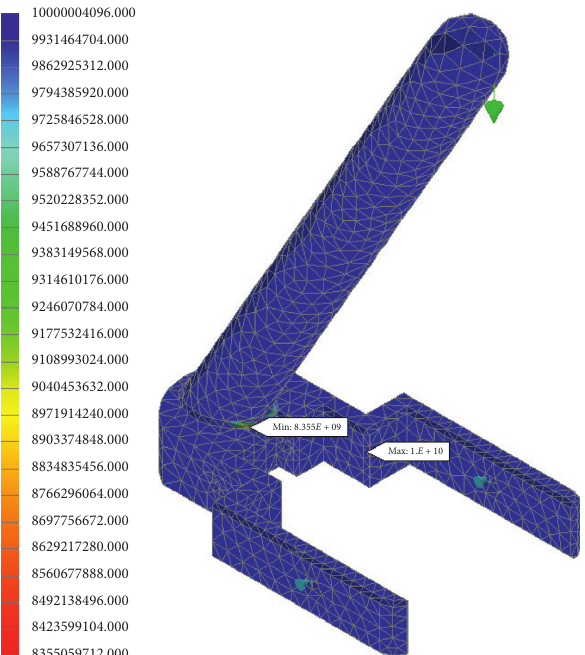
Figure 11: Simulation results showing fatigue life for the handle.